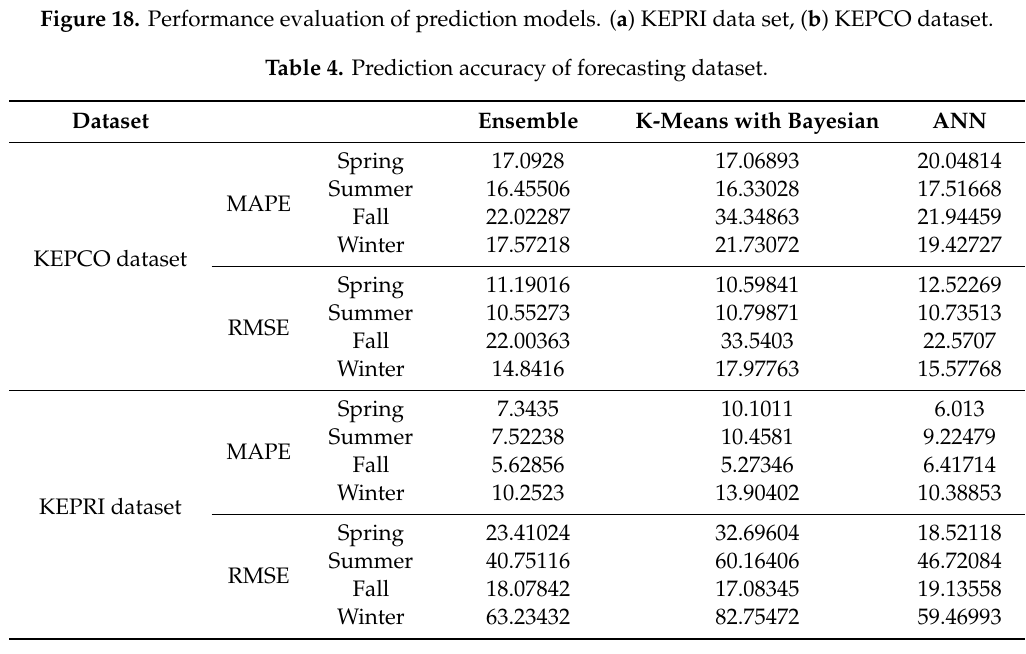
Figure 18. Performance evaluation of prediction models. ( a ) KEPRI data set, ( b ) KEPCO dataset.